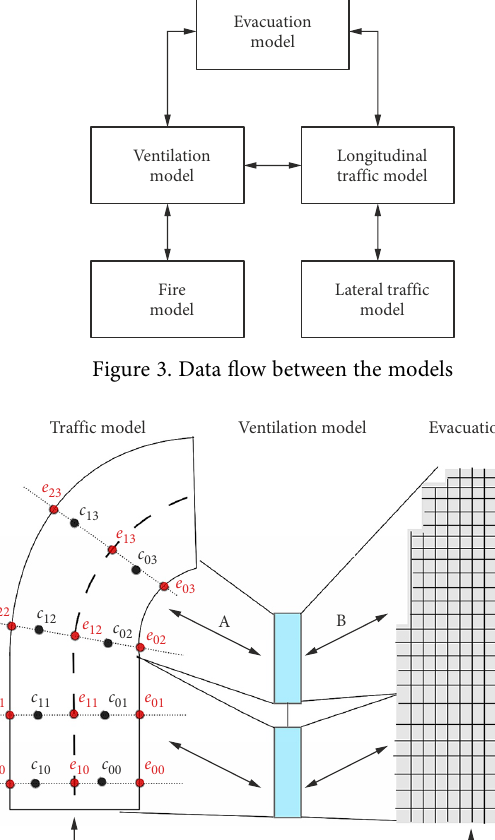
Figure 4. Coordinate system mapping between different simulator